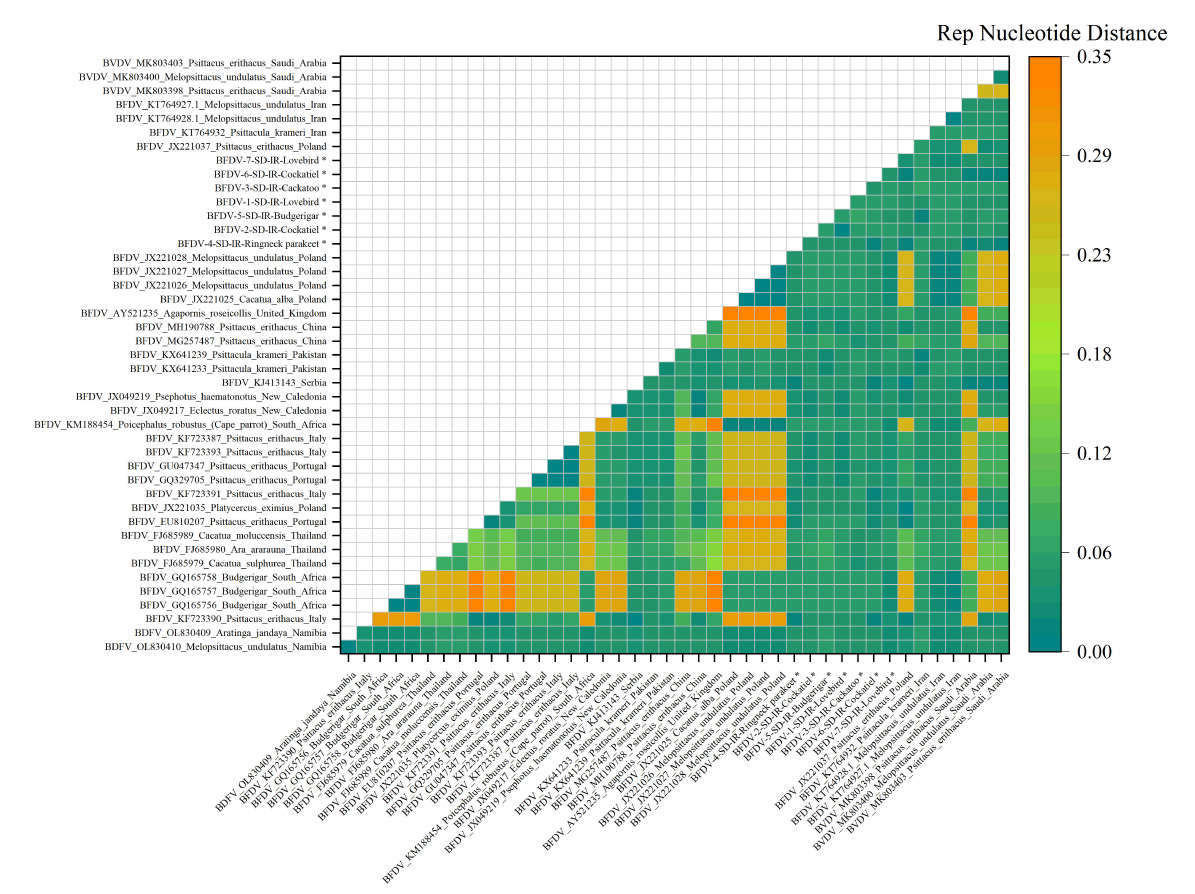
FIGURE5 An illustration of the pairwise distance between rep nucleotide sequences based on the pairwise deletion of gaps in all seven rep and 36 GenBank sequences. The labels represent the sequence information within GenBank with year of sample collections, GenBank accession number, the name of bird, and the country of host. All rep sequences of this study are marked with a black star